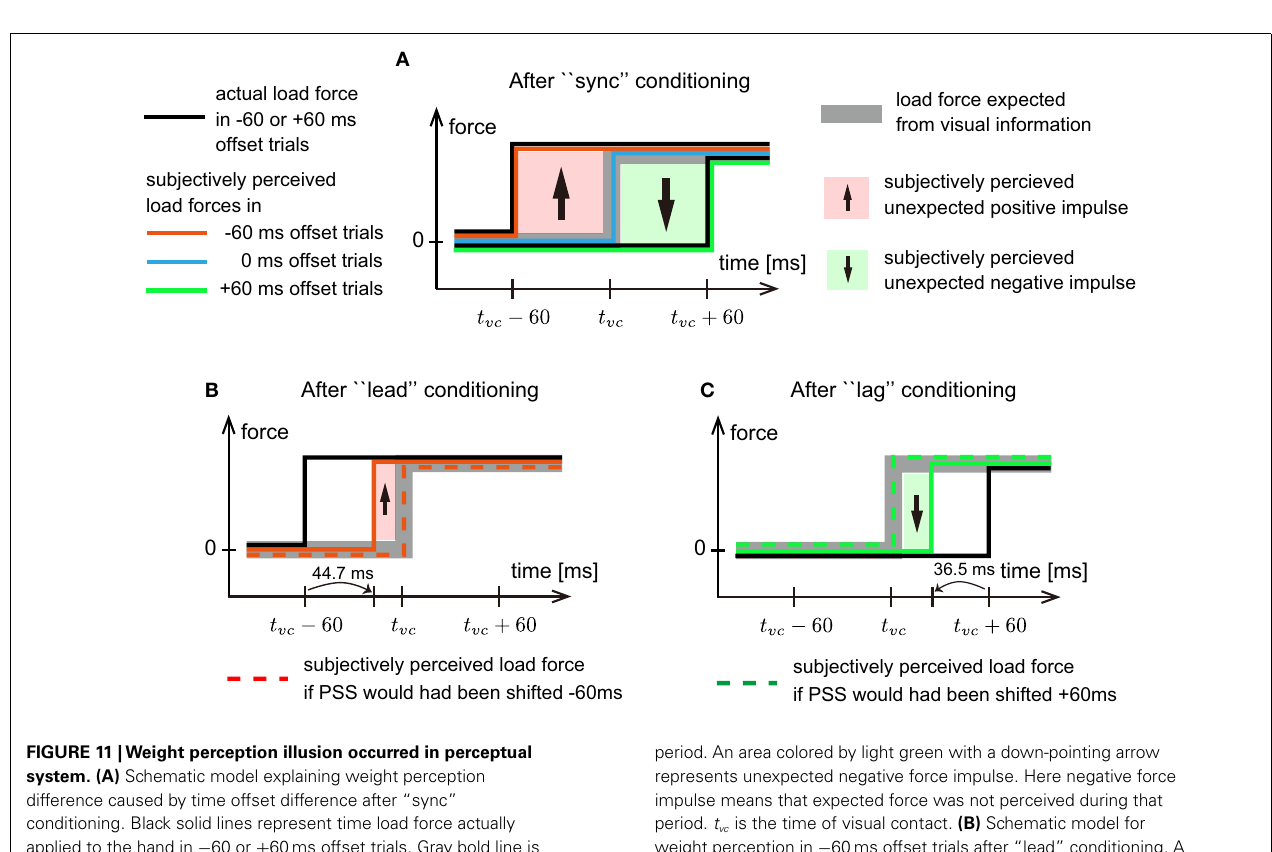
FIGURE 11 |Weight perception illusion occurred in perceptual system. (A) Schematic model explaining weight perception difference caused by time offset difference after “sync” conditioning. Black solid lines represent time load force actually applied to the hand in − 60 or + 60ms offset trials. Gray bold line is the load force expected from visual information. Red, blue, and green lines trace subjectively perceived load forces in − 60, 0, and + 60ms offset trials, respectively. Note that perceived load forces are coincided with subjectively perceived timings of load force exertion. An area colored by light red with an up-pointing arrow represents unexpected positive force impulse. Here positive force impulse means that unexpected force was perceived during that